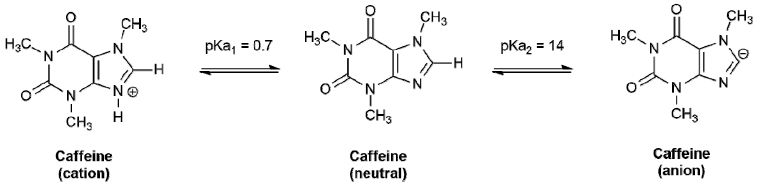
Figure 15. Acid/base equilibrium of caffeine.